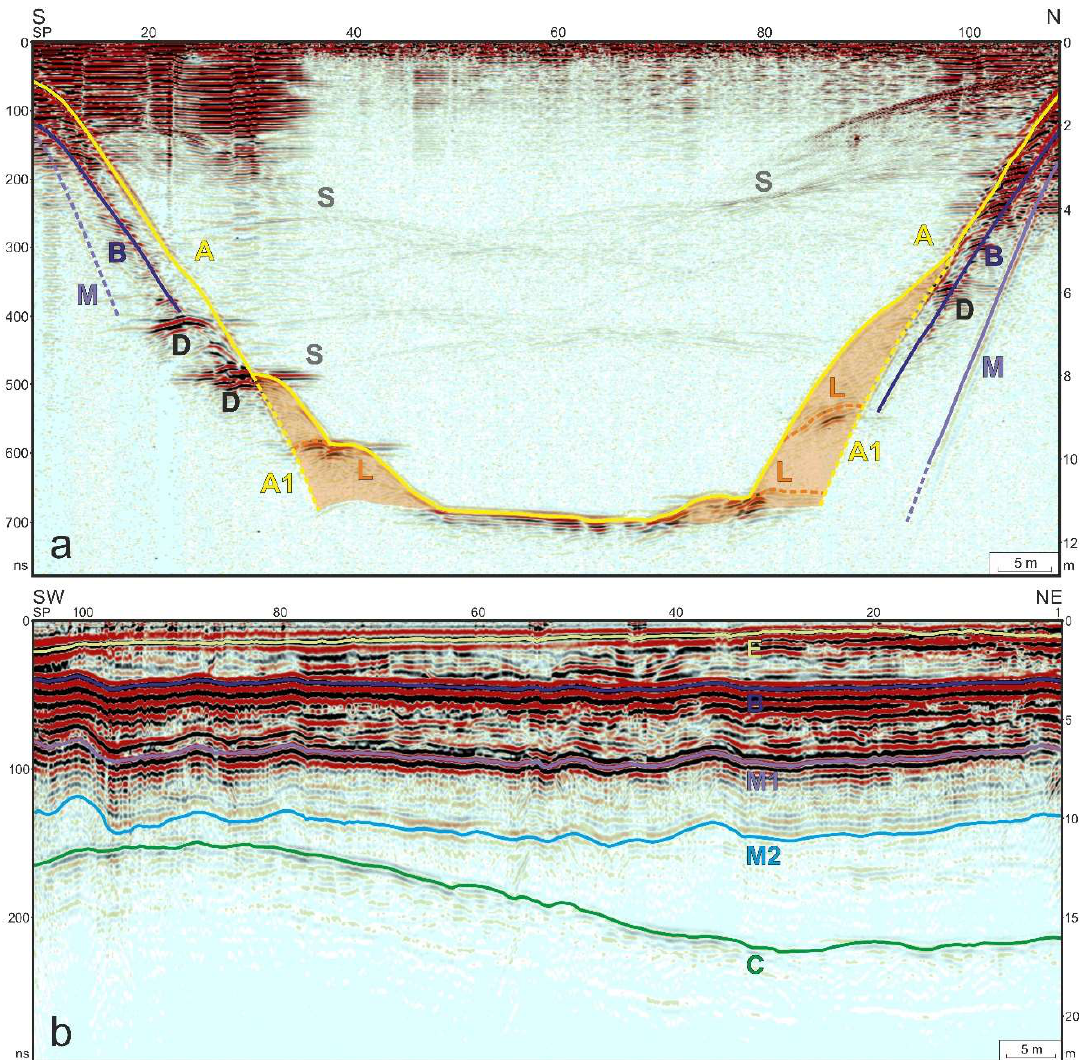
Figure 8. GPR sections for lines 23, across the crater lake ( a ) and 7, on the left, southeastern bank ( b ). Legend: reflections from the bottom (A), older bottom (A1), the top of permafrost (B), the base of the massive ground ice (C), base of the upper soil layer (E), multiple reflections from the crater bottom (M) and the top of permafrost (M1 and M2), side reflections (S), diffracted waves (D), landslides blocks (L, orange-shaded).